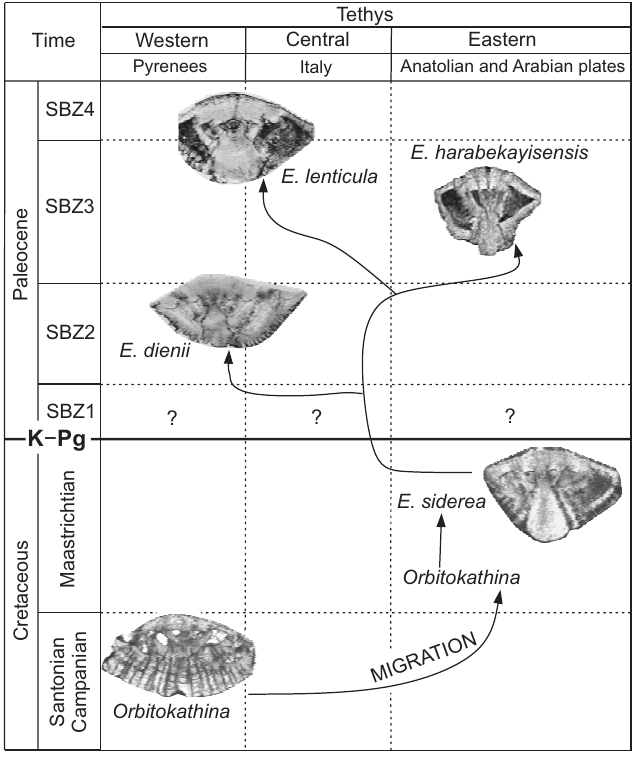
Fig. 7. Schematic representation of Elazigina evolution through time. Images not to scale, modified from Boix et al. (2009); Serra-Kiel et al. (2016); Hottinger (2014). Shallow Benthic Zones (SBZ) according Serra- Kiel et al.